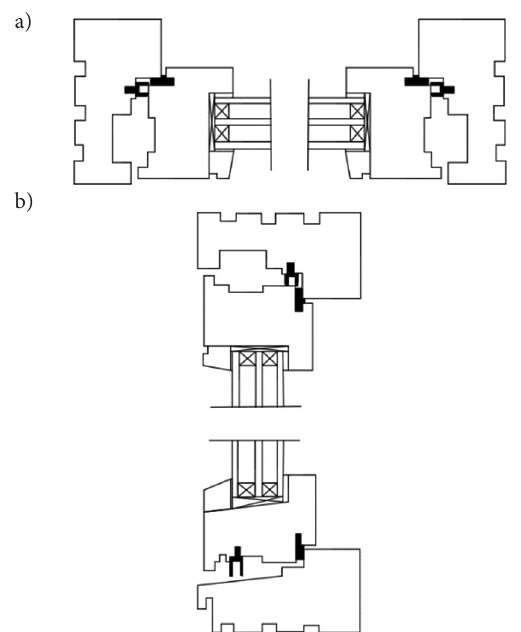
Figure 5. Cross section of European type window: